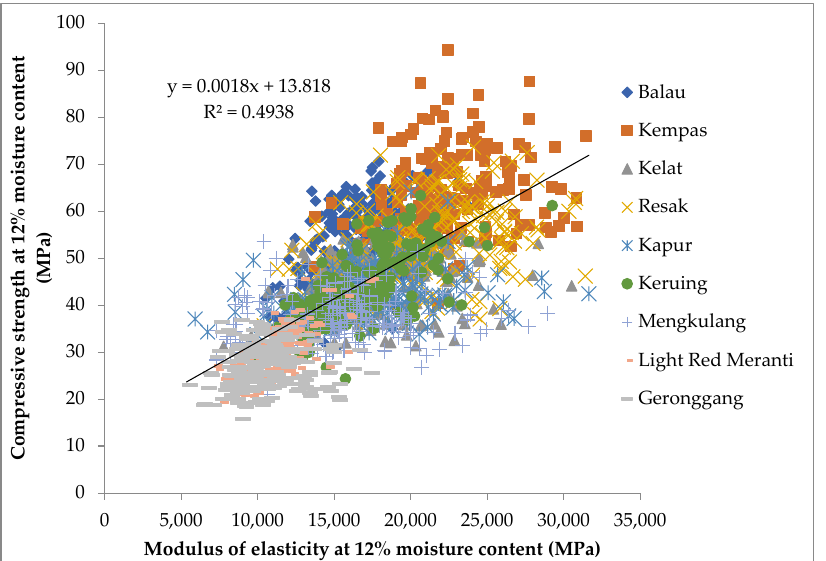
Figure 4. Relationship between compressive strength parallel to the grain and modulus of elasticity for selected Malaysian tropical hardwood timber.